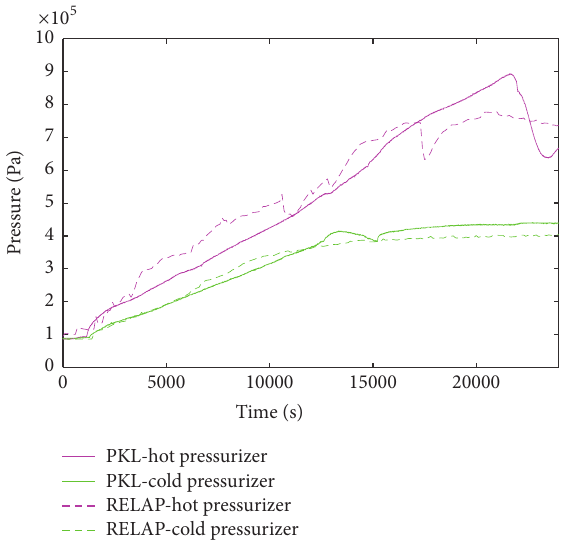
Figure 8: Pressure. PKL versus RELAP5. Temperature influence. Phase I.